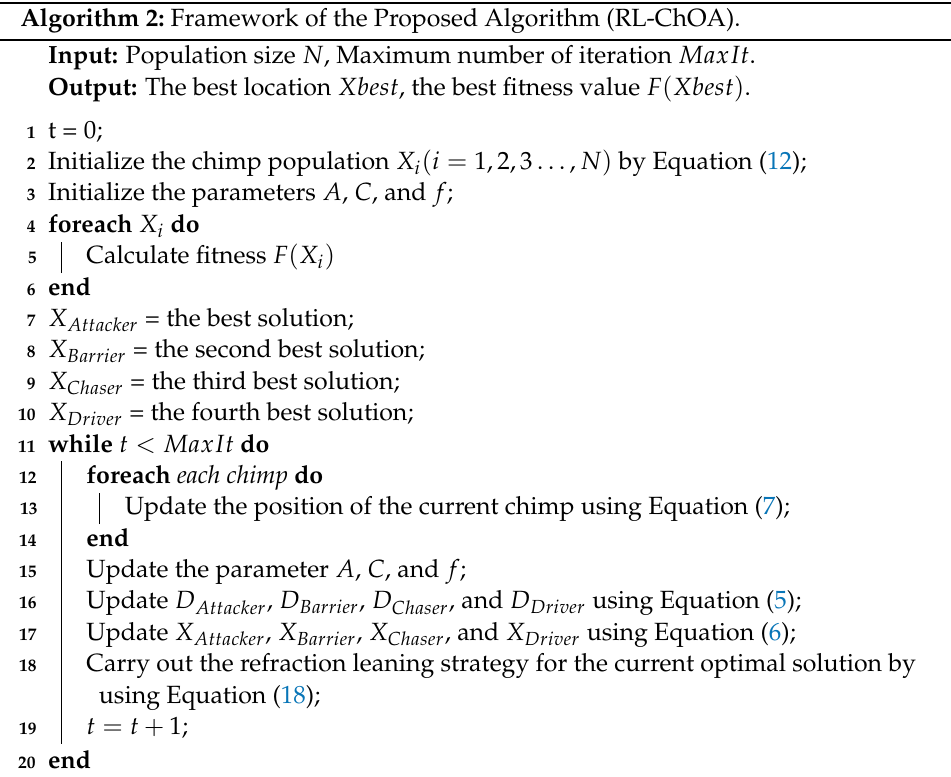
Algorithm 2: Framework of the Proposed Algorithm